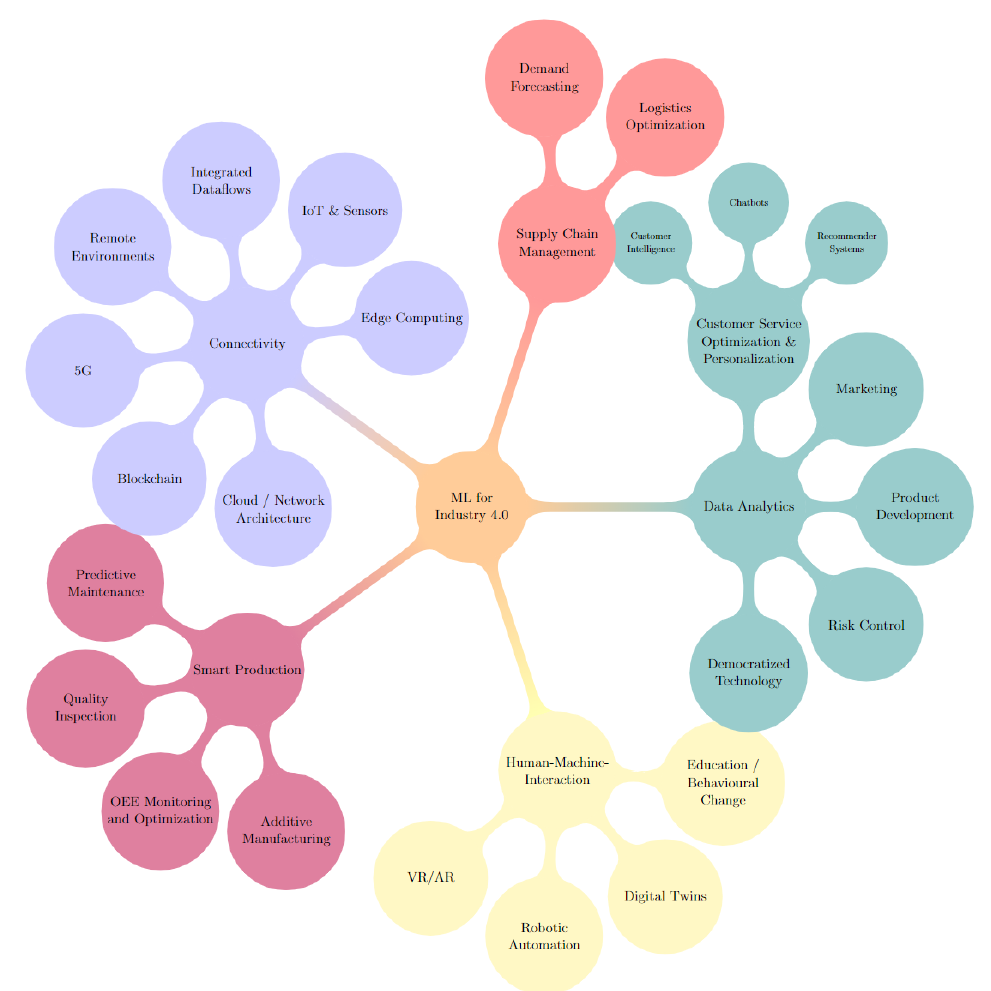
Figure 8. Mind map of high potential value areas for ML in industry 4.0, by mentions in top consulting companies’ white